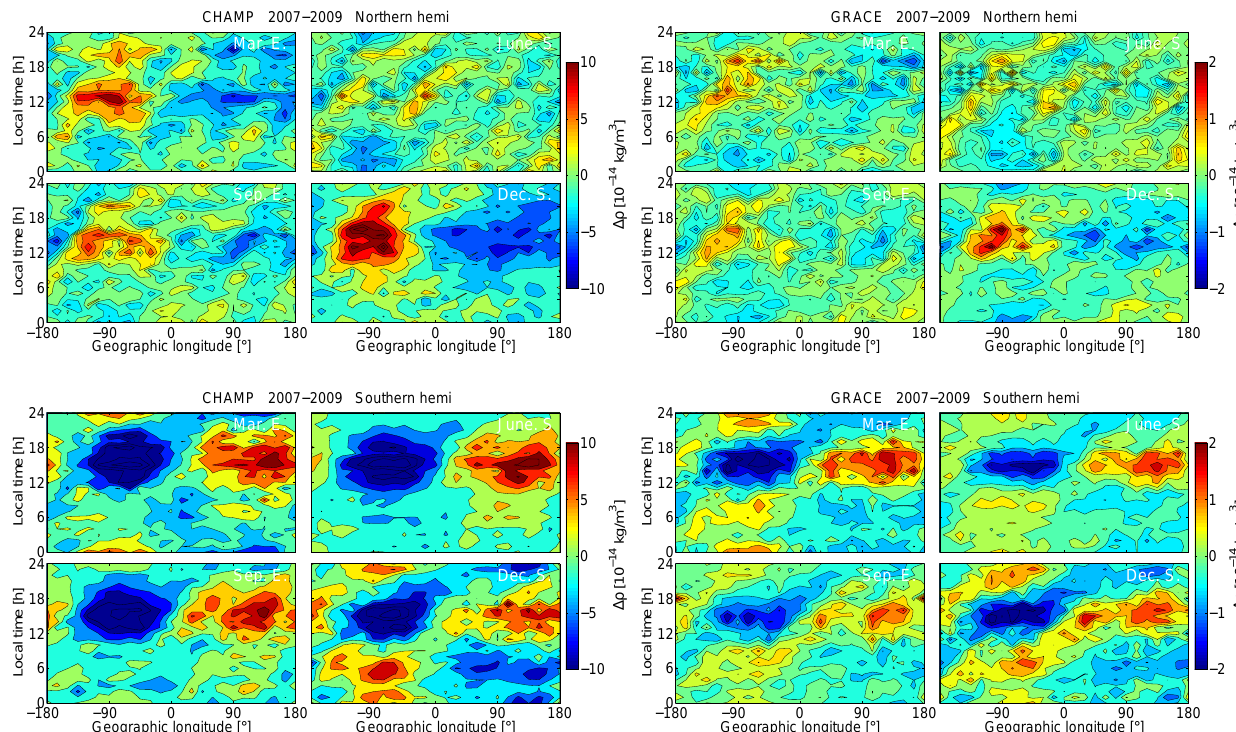
Figure 1. Local time versus longitudinal distribution of thermospheric mass density for four seasons in the Northern (top) and Southern (bottom) hemispheres both from CHAMP (left) and GRACE (right)